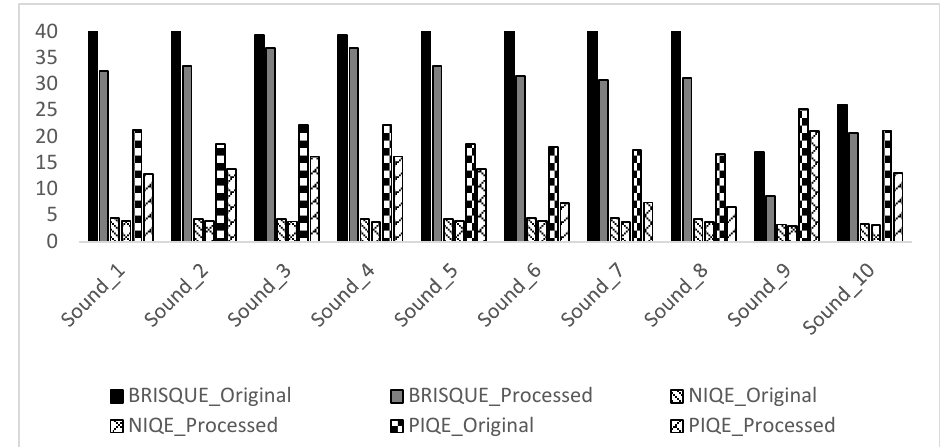
Figure 13. Comparison of quality metrics of original and preprocessed sound images .